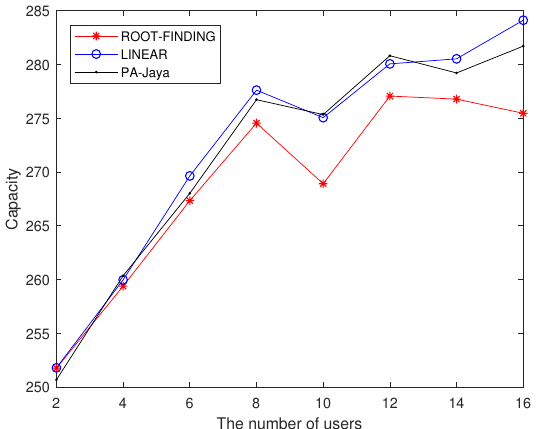
Figure 9. Comparison of different algorithms for capacity with different user